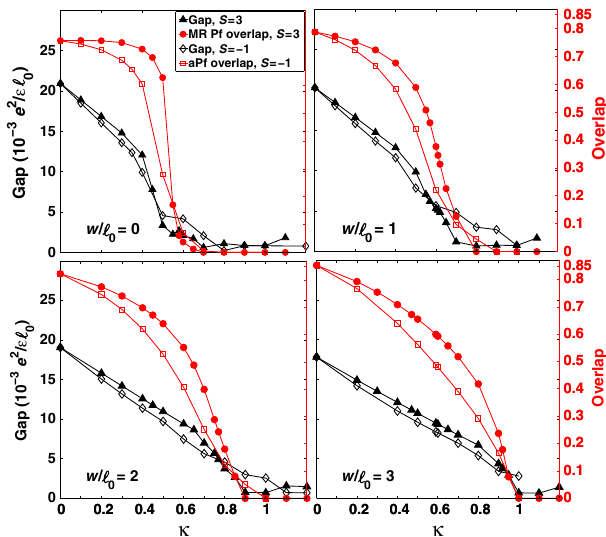
FIG. 5. The overlap between the ground state and the MR wave function as a function of κ , for w= l 0 ¼ 0 ; 1 ; 2 ; 3 , and 4. w= l 0 ¼ 0 is the leftmost curve, and w= l 0 ¼ 4 is the rightmost. The top panel is on the torus for N e ¼ 15 and the hexagonal unit cell, with the bottom panel for the sphere with N ϕ ¼ 29 with S ¼ 3 ( N e ¼ 16